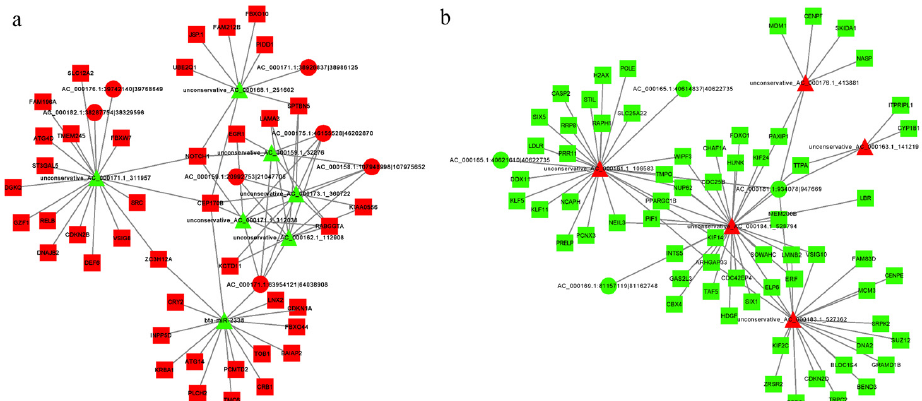
Figure 8. Construction of the circRNA–miRNA–mRNA ceRNA regulatory network. ( a , b ) circles represent circRNAs, triangles represent miRNAs, squares represent mRNAs, red indicates upregulation, and green indicates downregulation.